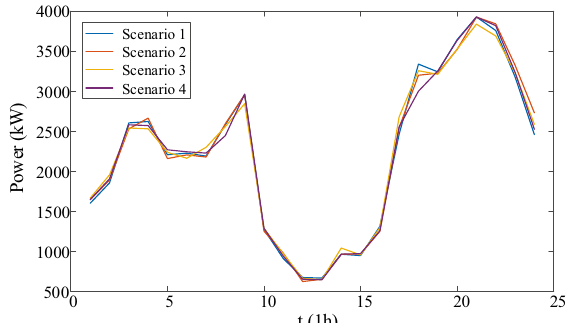
Figure 6. The scenario set of thermal load.